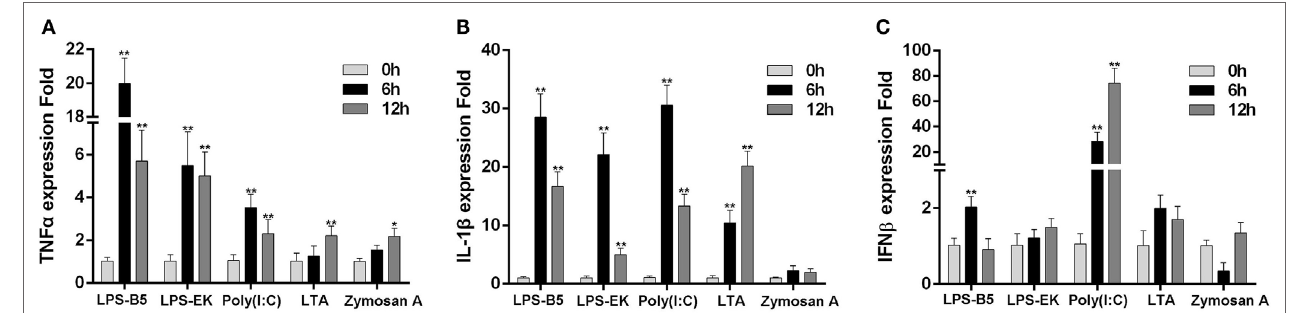
FigUre 1 | Lipopolysaccharide (LPS) can induce the inflammatory response. The expression profiles of TNF α (a) , IL-1 β (B) , and IFN β (c) in miiuy croaker macrophages that treated with LPS-B5, LPS-EK, poly(I:C), LTA, and Zymosan A, respectively, which were detected by using qRT-PCR. The expression of β -actin was used as the internal control, and the data were represented in the form of mean ± SE. The statistically significant differences between control and experience groups were indicated with asterisks (* P < 0.05 and ** P <